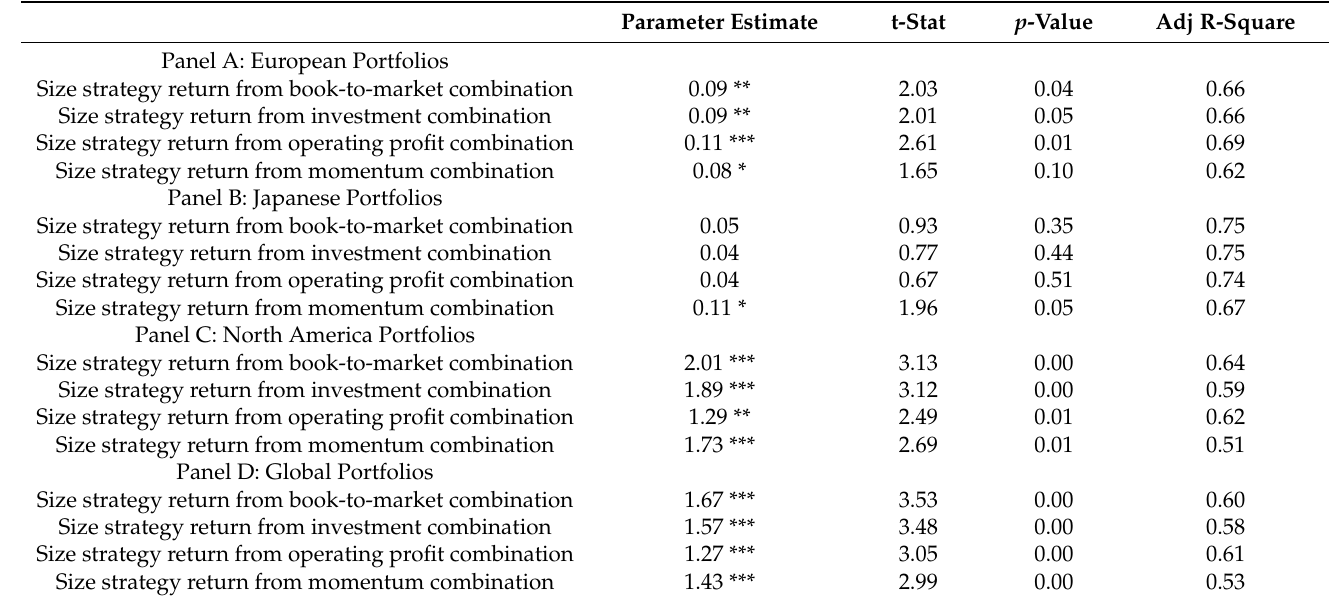
Table 13. Regression results: coefficient of sentiment change in the augmented FF3F model when size anomaly return is calculated with alternative